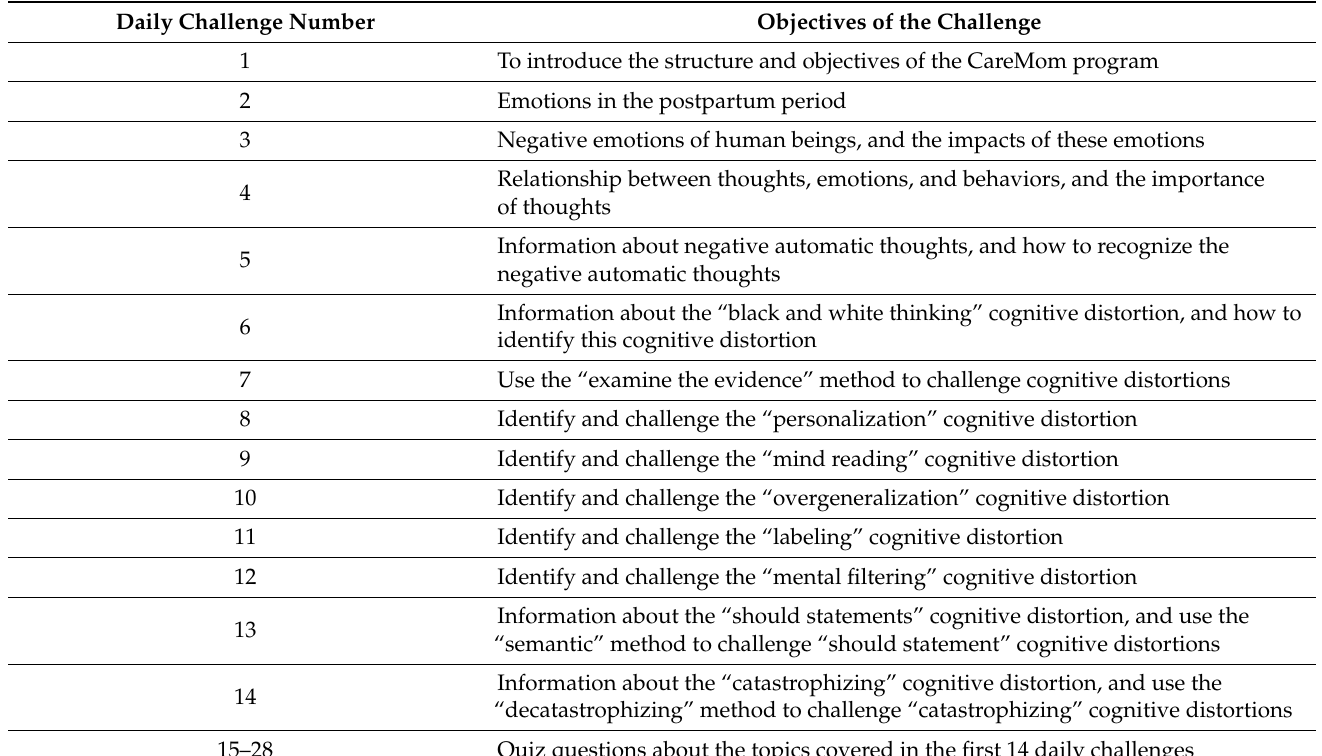
Table 1. Objectives of each daily challenge within the CareMom program.